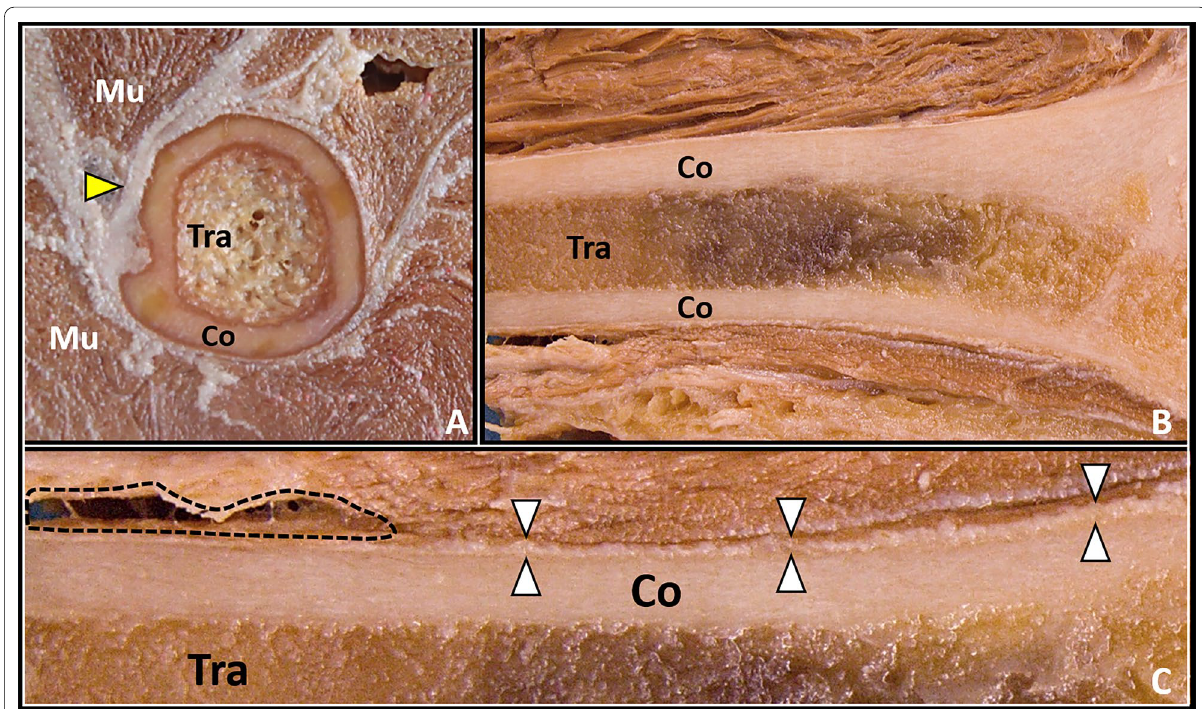
Fig. 1 Cadaveric anatomy of bone tissue. The bone presents an inner portion with a trabecular texture ( Tra ) and an outer component—compact in nature—known as cortical bone ( Co ) ( A , B ). Of note, the periosteum ( white arrowheads ) tightly envelops the surface of the bone and, if damaged, allows the blood to diffuse toward the epi-periosteal space ( black dotted line ) ( C ). Mu: muscle tissue, yellow arrowhead: fat